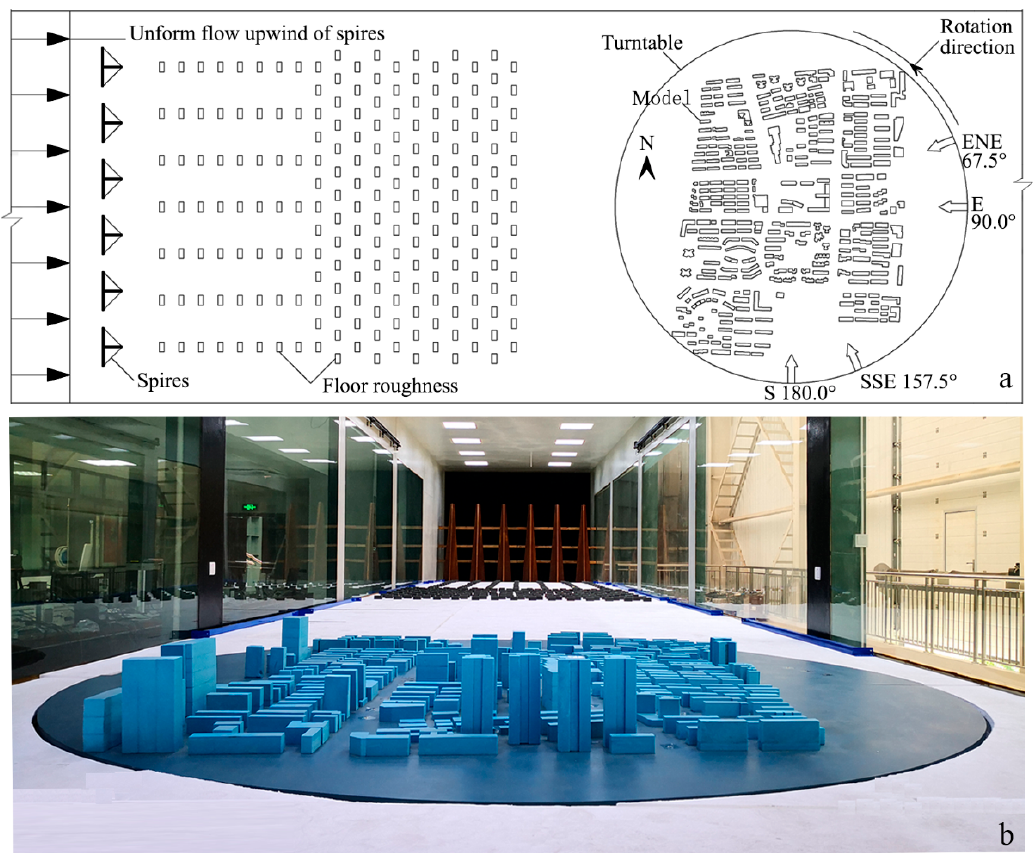
Figure 3. Schematic of the blocking rate ( η ) calculation. ( a ) The maximum vertical cross-sectional area ( A b ) of the study object. ( b ) η calculation schematic.